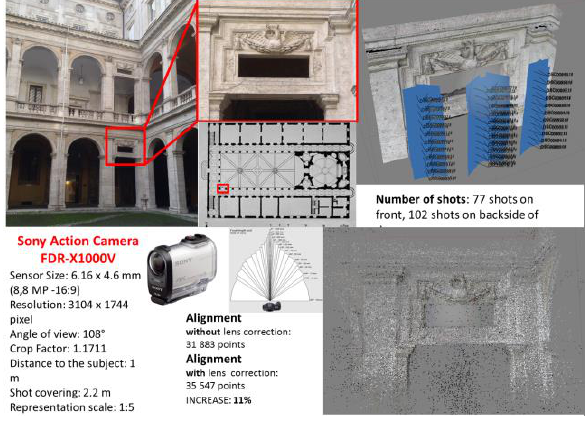
Figure 8. shooting and processing phases